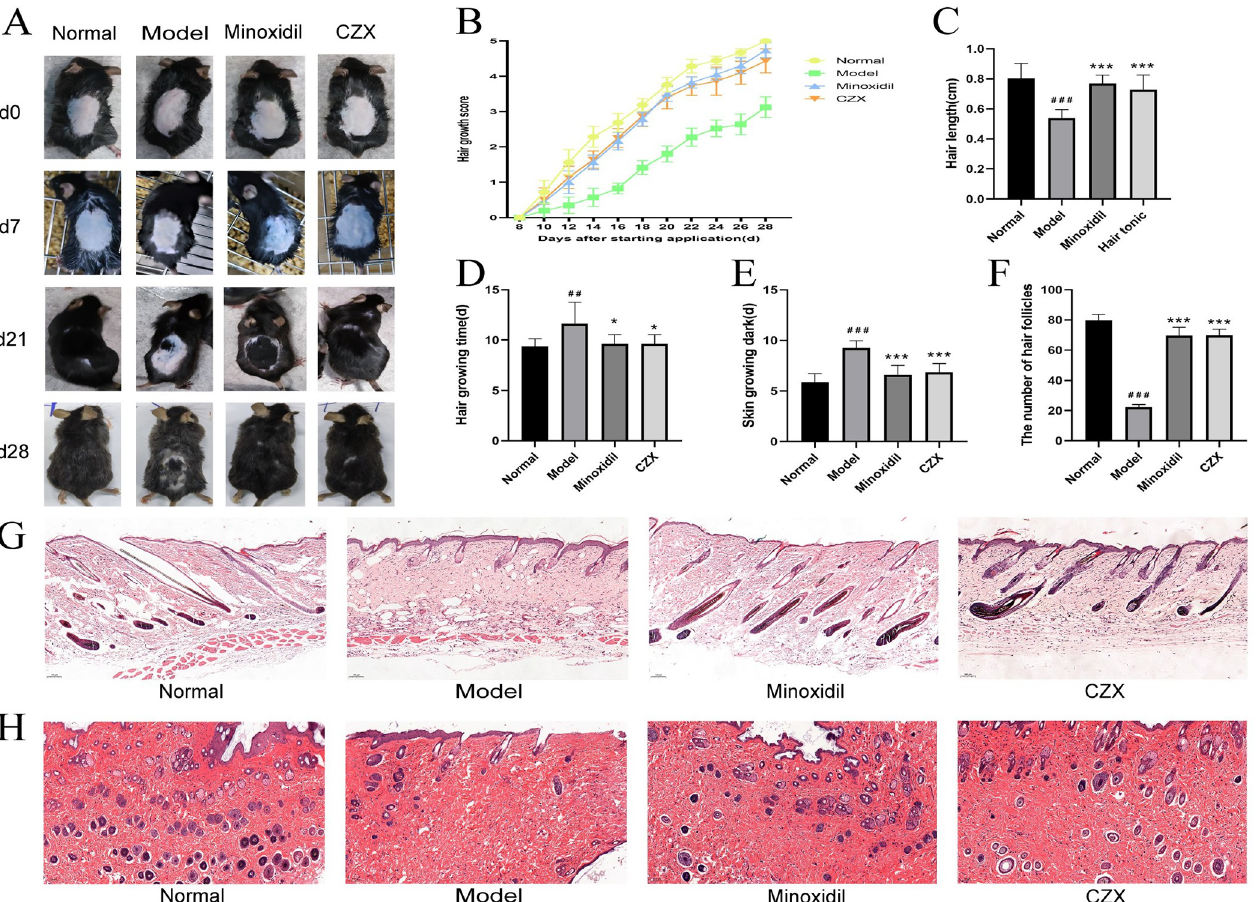
Fig 1. Effect of CZX on the hair cycle and hair follicle morphology in mice. (A) The backs of the mice were shaved and then treated with 95% ethanol, minoxidil and CZX. (B) Hair regrowth scores were determined every other day starting on the 8th day after treatment. (C) Average hair length of the mice in each group. (D) and (E) Skin regrowth times and skin darkening times. (F) The number of hair follicles. (G) and (H) Longitudinal and transverse sections of the dorsal skin. Digital images were captured using a 50 × magnification light microscope. The results are presented as the mean ± SD. Compared with the normal group, ## P < 0.01, ### P < 0.001; compared with the model group, � P < 0.05, ��� P < 0.001, n = 8.